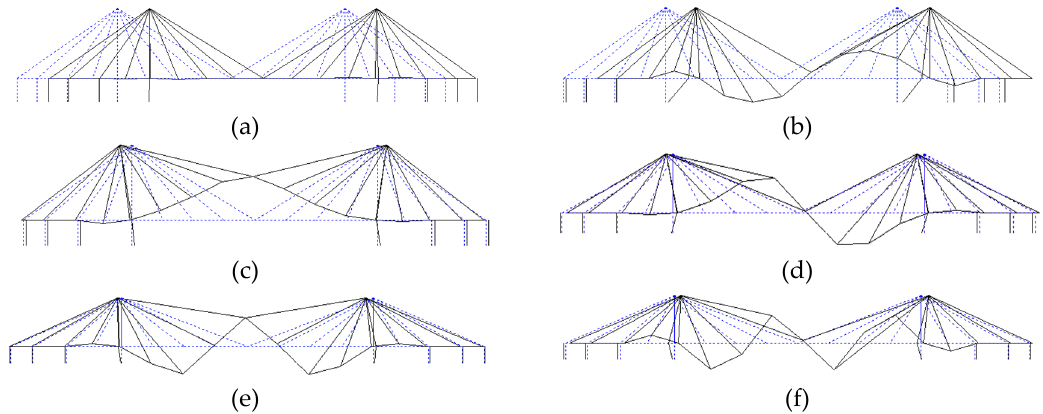
Figure 8. Identified modal shapes and frequencies ( a ) the 1 st mode, f v1 = 0.79 Hz; ( b ) the 2 nd mode, f v2 = 6.61 Hz; ( c ) the 3 rd mode, f v3 = 9.34 Hz; ( d ) the 4 th mode, f v4 = 14.19 Hz; ( e ) the 5 th mode, f v5 = 20.97 Hz; ( f ) the 6 th mode, f v6 = 27.16 Hz.